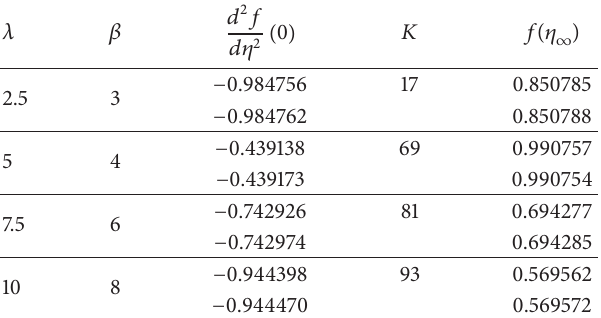
Table 4: Least possible 𝛽 (in whole numbers) for 𝜆 > 2 , 𝛾 = 0